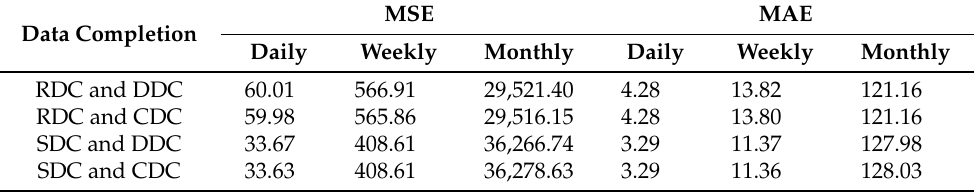
Table 8. Performance of the E XPECT framework using the different data completion methods.